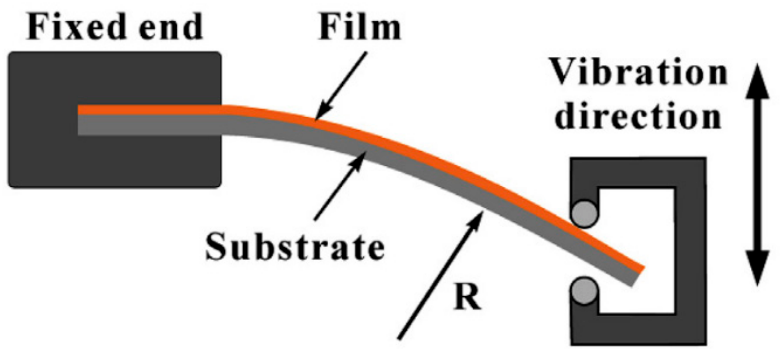
Figure 12. Dynamic bending setup with full reverse loading. Adapted from [74,100].